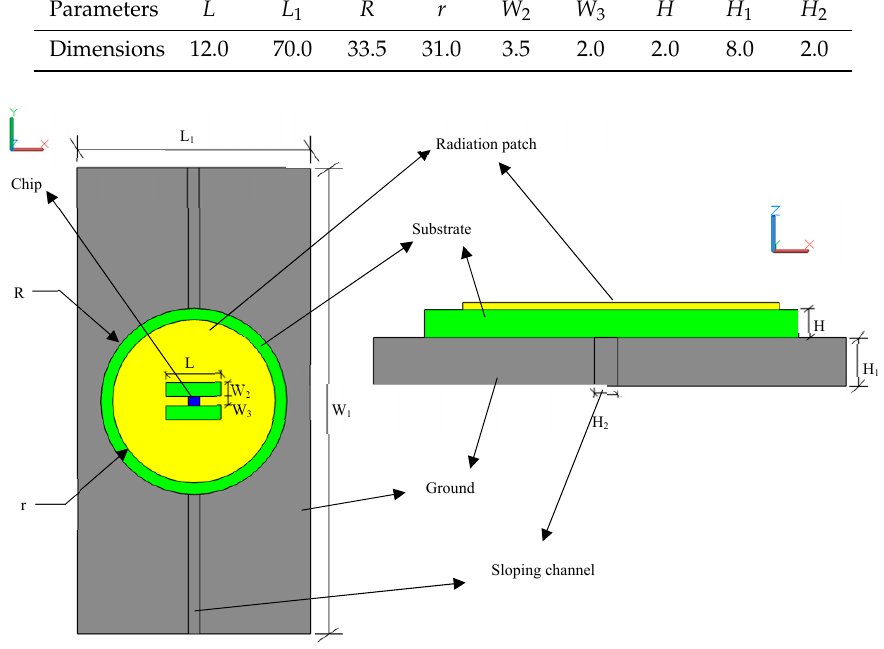
Table 1. Optimal dimension of the model (Unit: mm)